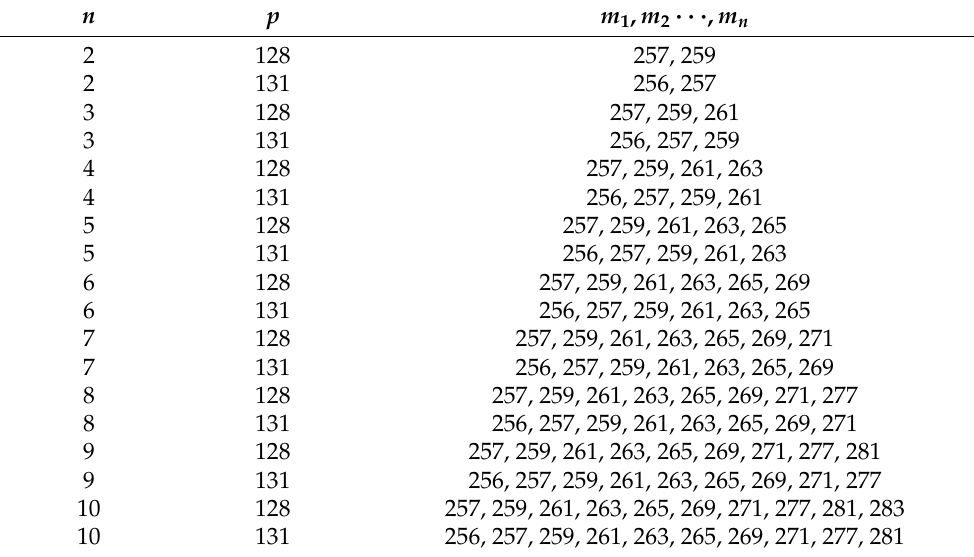
Table 2. Available parameters of m 1 , m 2 · · · , m n . n